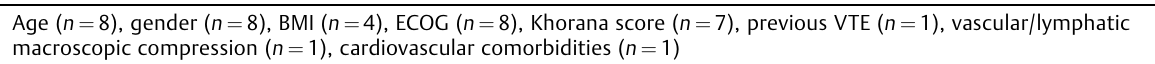
Table 3 Classi fi cation of prognostic factors and number of studies reporting on each Patient